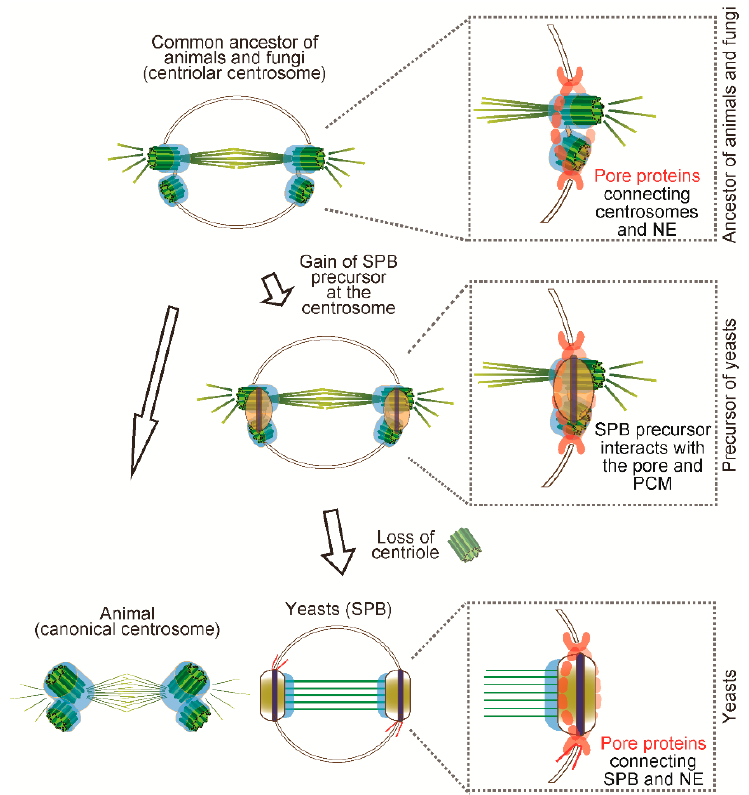
Figure 4. Speculated scenario of centrosome evolution. The common ancestor of fungi and animals is